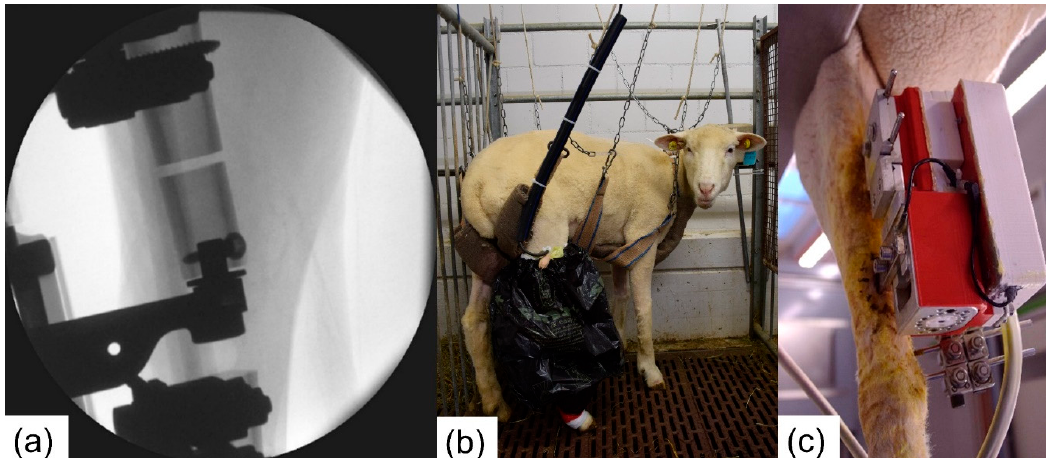
Figure 5. ( a ) Intraoperative radiograph showing the attachment of the force sensor on the mobile fragment and the 3.0 mm experimental defect. ( b ) Postoperative housing of the animals in the sling system. ( c ) Active fixator and attached control unit in the in vivo trial.